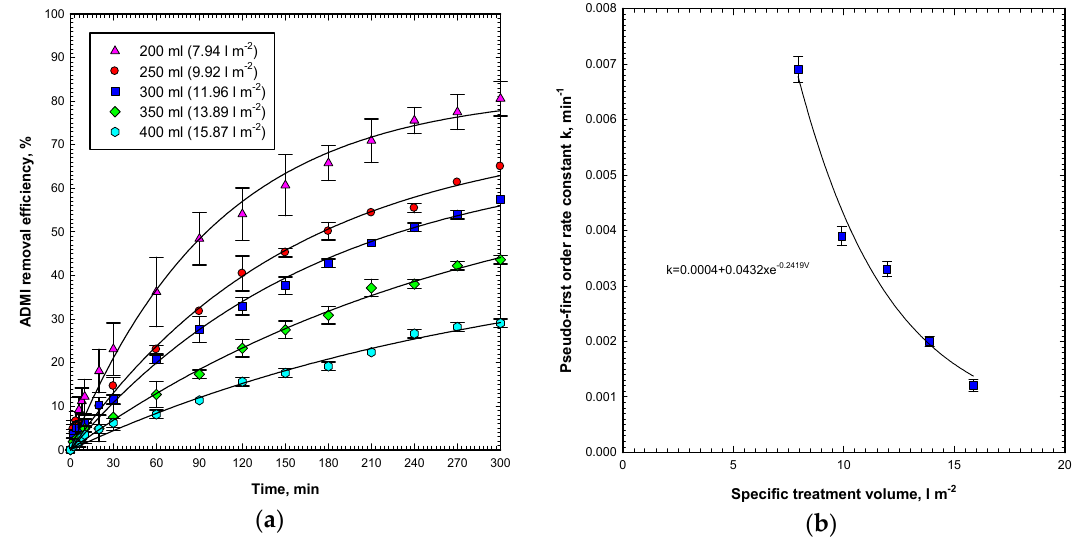
Figure 8. Effect of the treatment volume on ( a ) OG degradation and ( b ) the first-order rate constant, by the Vis/ZnO process. The operating conditions were: initial OG concentration of 50 mg L − 1 , ZnO dosage of 60 g m − 2 , visible light intensity of 9600 Lux, treatment volume of 200–400 mL, and a reaction time during of 300 min.